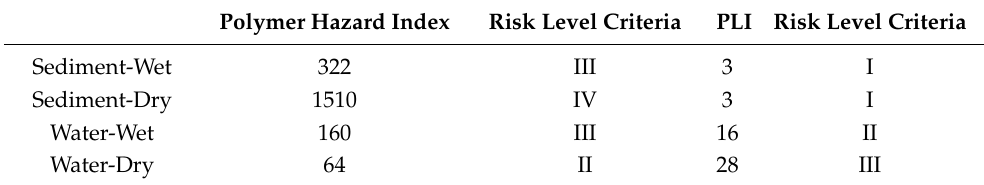
Table 2. Risk level criteria of microplastics in the reservoir during wet and dry